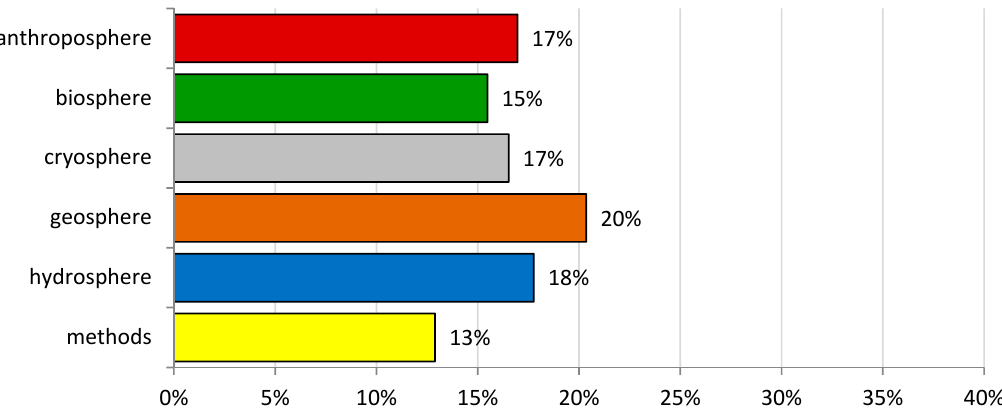
Figure 3. Histogram of TerraSAR-X related fields of research, expressed in percent based on the analysis of 1636 proposals.